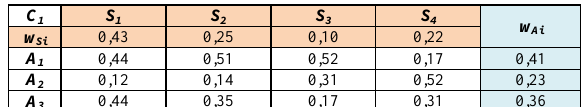
Table 3. Matrix of pairwise comparisons of the sub-criteria in relation to the criterion C 2